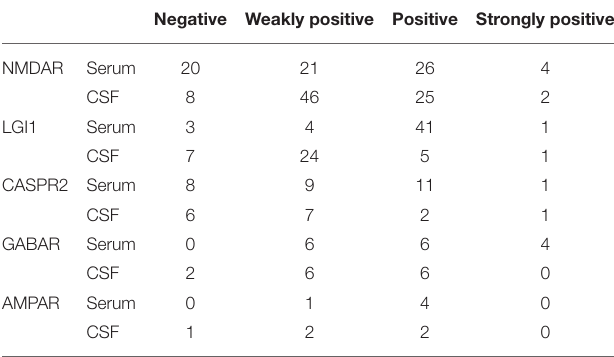
TABLE 3 | Details of antibody titers in the CSF and serum of antibody-positive